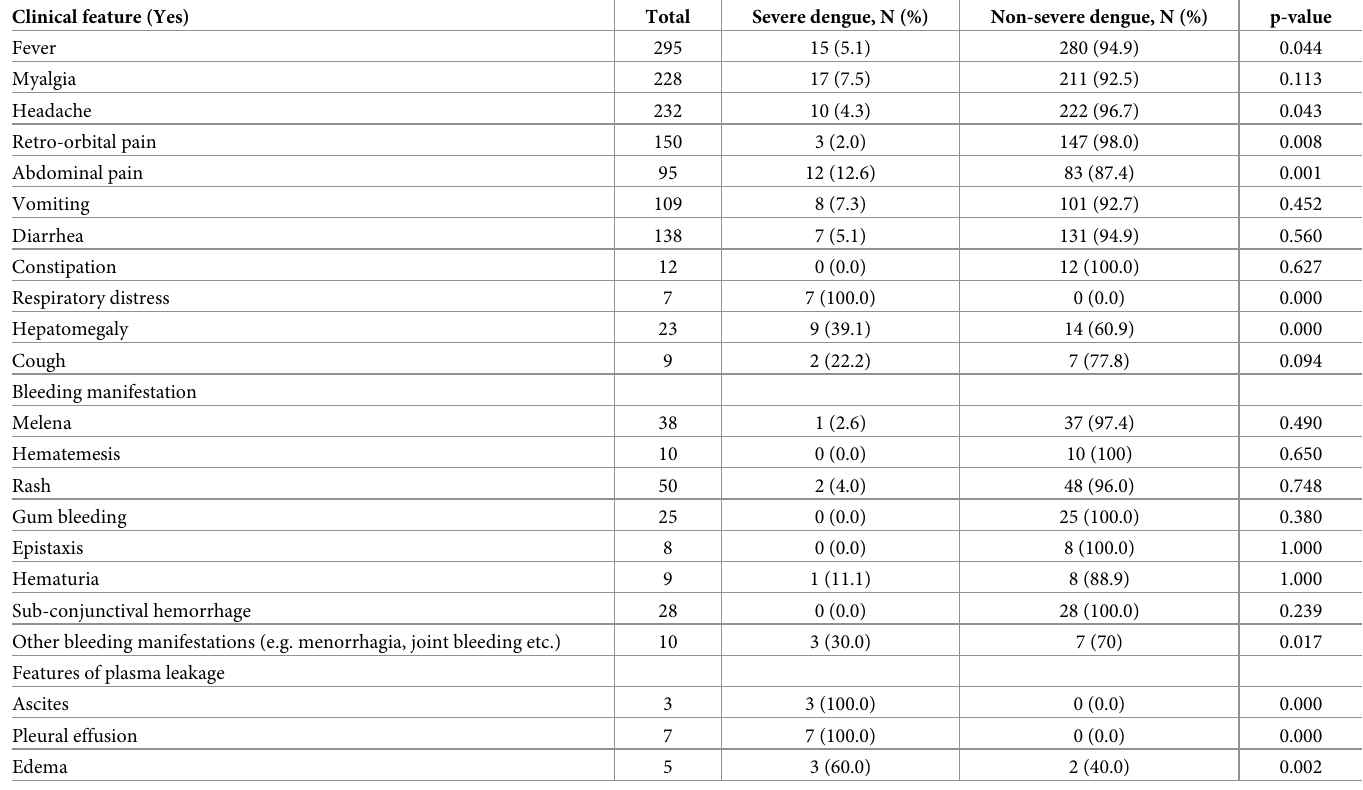
Table 2. Clinical presentations of dengue cases at the time of hospital visit (n =